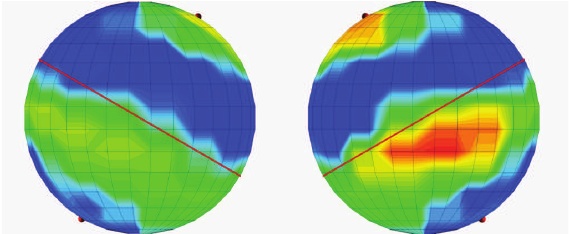
Figure 5: An example model of BY Cam with dipole plus quadrupole components with accretion regions, just below the magnetic equator (see right panel) and the magnetic north